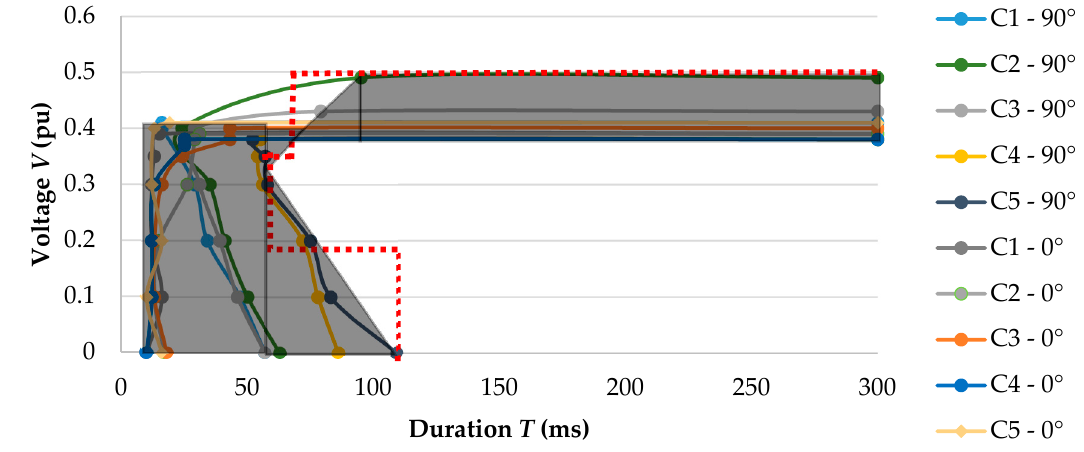
Figure 7. Area of uncertainty for contactors (shaded area), curve modification for phase instant 0° (red dotted line).